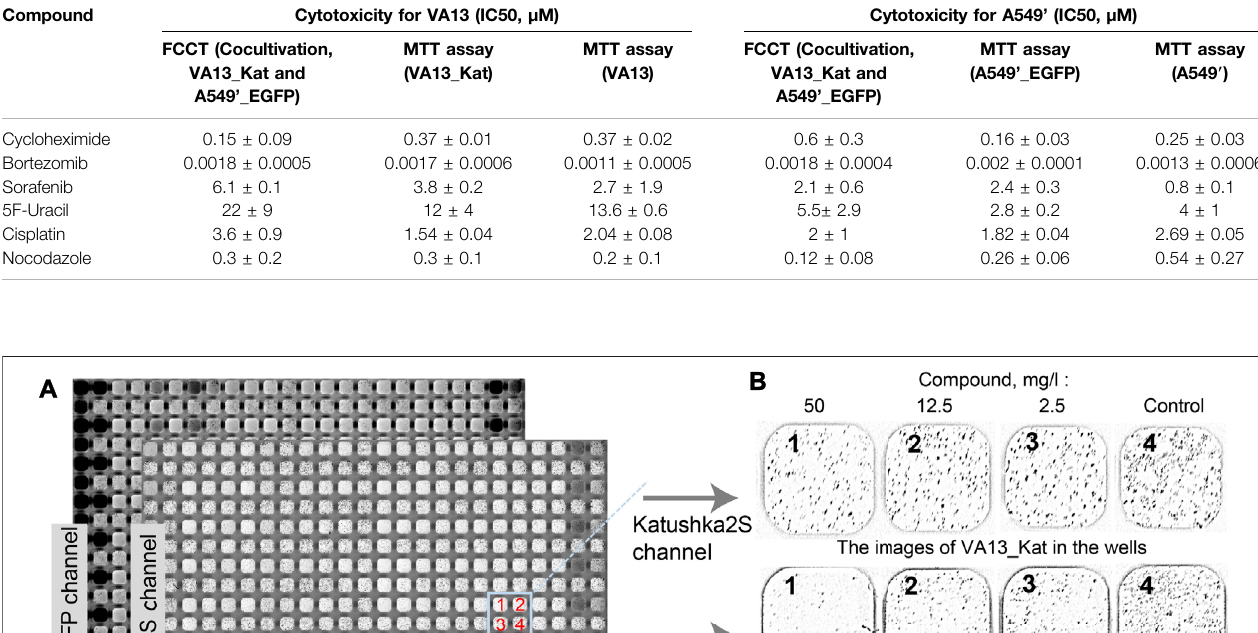
TABLE 1 | Cytotoxic action (IC50) of known drugs on A549 ’ , VA13 cell lines, and their derivatives after 72 h of incubation. The cytotoxicity for the cocultures was obtained with the FCCT. For the monocultures, the data were assessed by MTT assays.